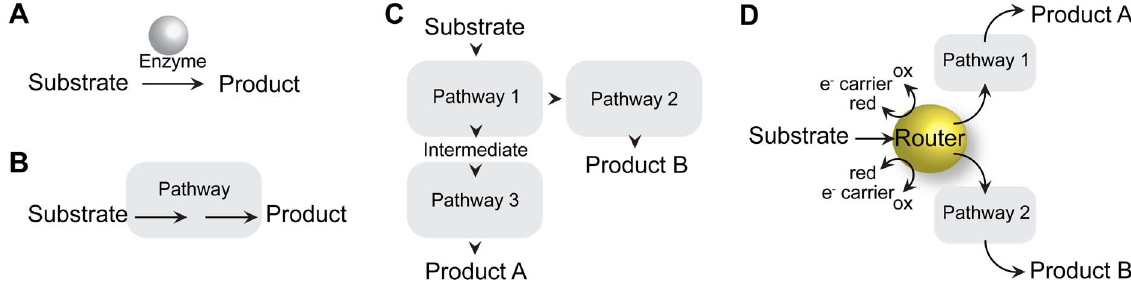
Figure 1. Organization of cellular metabolism. Metabolic reactions in a cell can be catalyzed by A , individual enzymes, or B , multienzyme complexes that channel substrates and/or sequester intermediates in a pathway. Pathways in the cell can be connected in series, C , or in parallel by D , metabolic ‘‘routers’’ that channel electrons and substrates to either of two metabolic pathways.